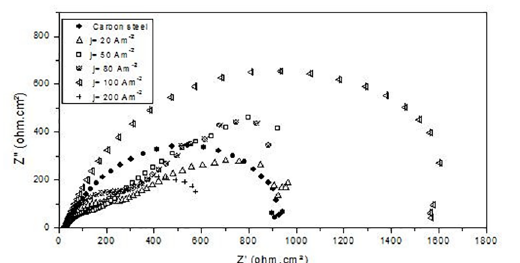
Figure 5. Nyquist diagrams for the Cu-Sn coatings and the carbon steel after 1 hour of stabilization in NaCl 0.5 mol L -1